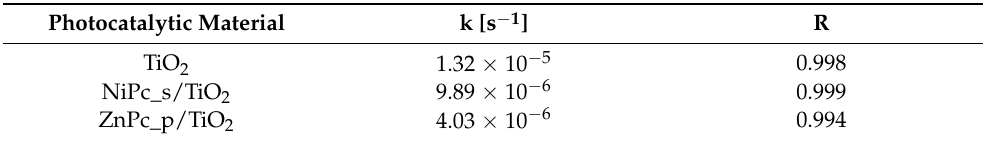
Table 8. The SMX degradation reaction rate constants (first-order reaction model) under UV irradia- tion with Pc-grafted TiO 2 composites in water (Figure